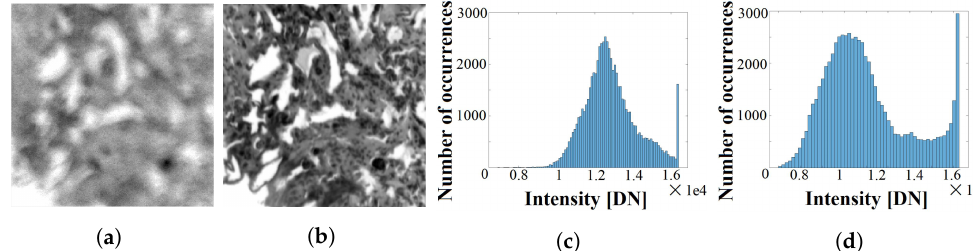
Figure 7. Brain histology sample from our database: ( a ) band 321 (633 nm), blurry and difficult to be used for sub-pixel motion estimation, with ( c ) its corresponding histogram of intensities; ( b ) obtained image from PCA that will be used for motion estimation, and ( d ) its associated